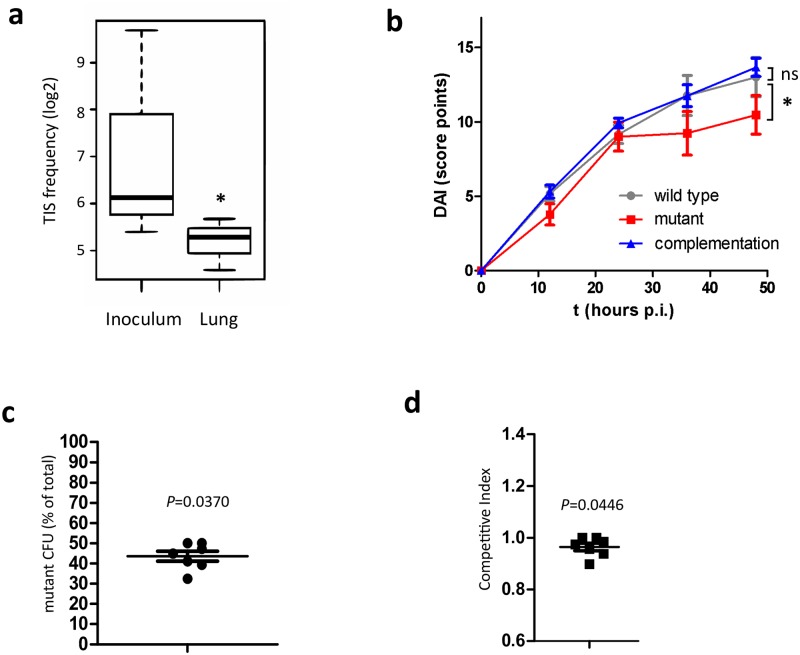
The S. aureus NRPS is required for full virulence in S. aureus-induced pneumonia.
a) Next-generation sequencing of transposon insertion sites was used to detect changes of read frequencies in bacteria from transposon mutant recovered from mouse lungs when compared to the inoculum library. The box and whisker plot represents the median and range of the relative difference (log2 fold change) in frequency of transposon insertion sites detected in ausA (see also S5 Table). b) ausB mutants are attenuated in a pneumonia infection model. S. aureus JE2, an isogenic ausB mutant, as well as the ausB complementation strain were instilled intranasally into Balb/c mice (n = 10) and animal health (disease activity index, DAI) was continuously recorded over 48 hours at the indicated time points. The graph shows mean DAI ± SEM. Statistics were determined by linear models of DAI as a function of infection group and time; *P<0.05. c) In vivo competition of a 1:1 mixture of wild-type and the ausB mutant strain at a sublethal dosage shows that the mutant is outcompeted by the wild-type. Although these effects were subtle, ausB mutants are recovered at reduced frequencies (43.55% of total CFU, P = 0.037 for difference from 50%). d) The resulting competitive index of 0.96 is only slightly, but significantly different from 1 (P = 0.0446).